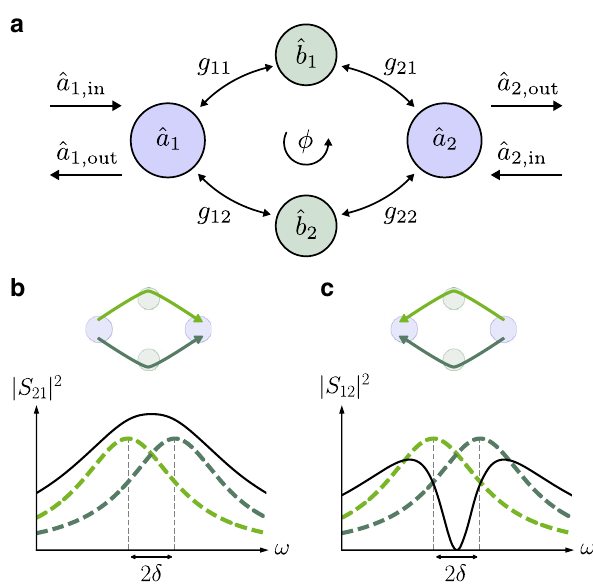
Fig. 1 Optomechanical nonreciprocal transmission via interference of two asymmetric dissipative coupling pathways. a Two microwave modes ^ a 1 and ^ b ^ b ^ a 2 are coupled via two mechanical modes 1 and 2 through optomechanical frequency conversion (as given by the coupling constants g 11 , g 21 , g 12 , g 22 ). Nonreciprocity is based on the interference between the two optomechanical (conversion) pathways g 11 , g 21 and g 12 , g 22 , in the presence of a suitably chosen phase difference ϕ between the coupling constants as well as the deliberate introduction of an asymmetry in the pathways. b , c The symmetry between the pathways can be broken by off-setting the optomechanical transmission windows through each mechanical mode ( dashed lines in dark and light green ) by a frequency difference 2 δ , resulting in different | S 21 | and | S 12 | ( solid lines ). Each single pathway, in the absence of the other mode, is described by Eq. (2). In the forward direction b , the two paths interfere constructively, allowing transmission and a fi nite scattering matrix element S 21 on resonance with the fi rst microwave cavity. In contrast, in the backward direction c , the paths interfere destructively, such that S 12 ≈ 0, thereby isolating port 1 from port 2 on resonance with the second microwave cavity. The isolation bandwidth is determined by the intrinsic dissipation rate of the